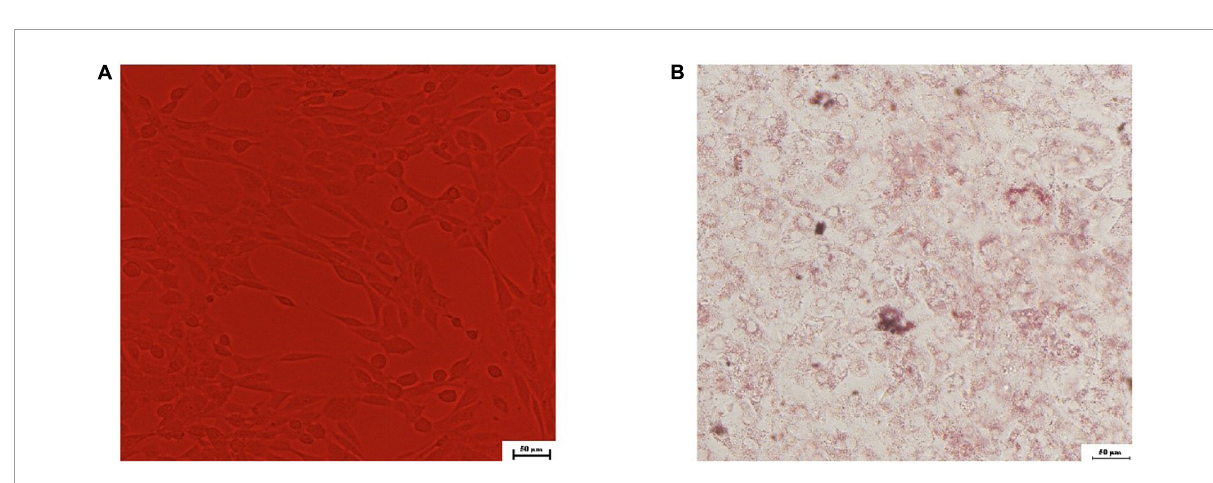
FIGURE3 Microscopic view of 3T3-L1 preadipocytes differentiated to adipocytes. (A) 0th day; (B) oil red O staining in the 8th